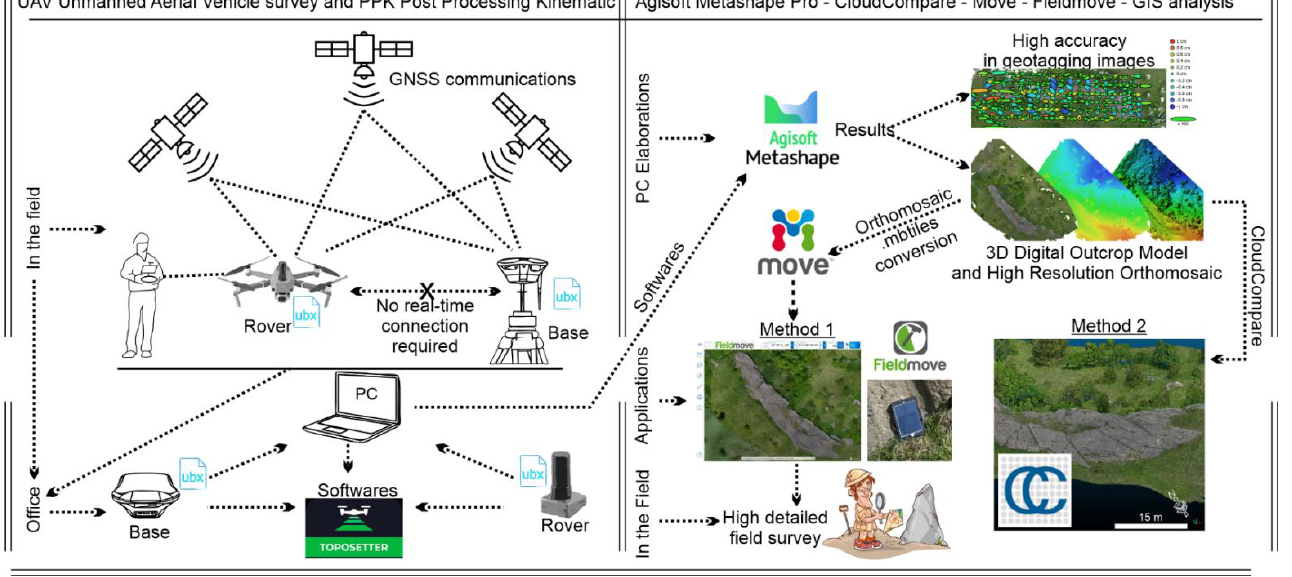
Figure 5. Synoptic workflow for the image acquisition from UAV and PPK, and data processing through the use of different software and PC elaborations, to collect and extract structural geological data with two different methods proposed in our work.